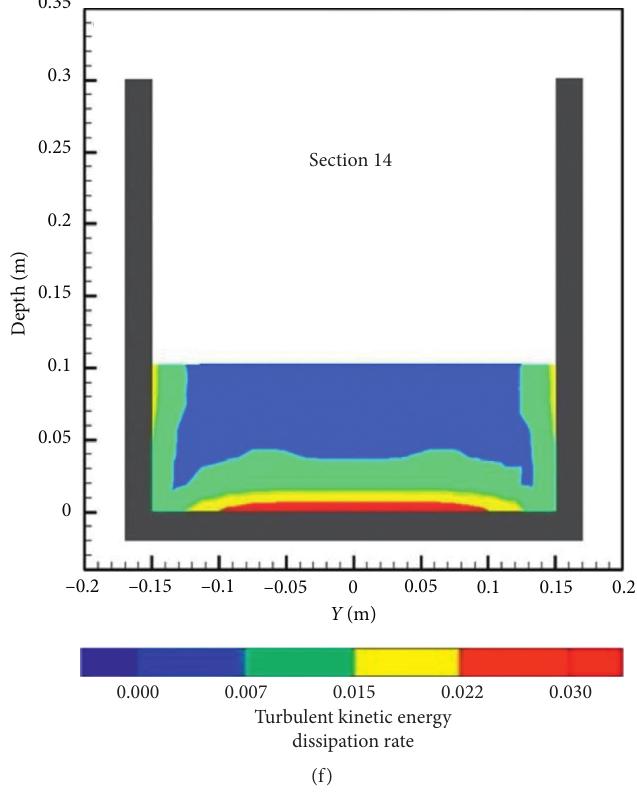
Figure 11: Development of cross-sectional turbulent kinetic energy dissipation rate (unit: m 2 · s − 3 ).